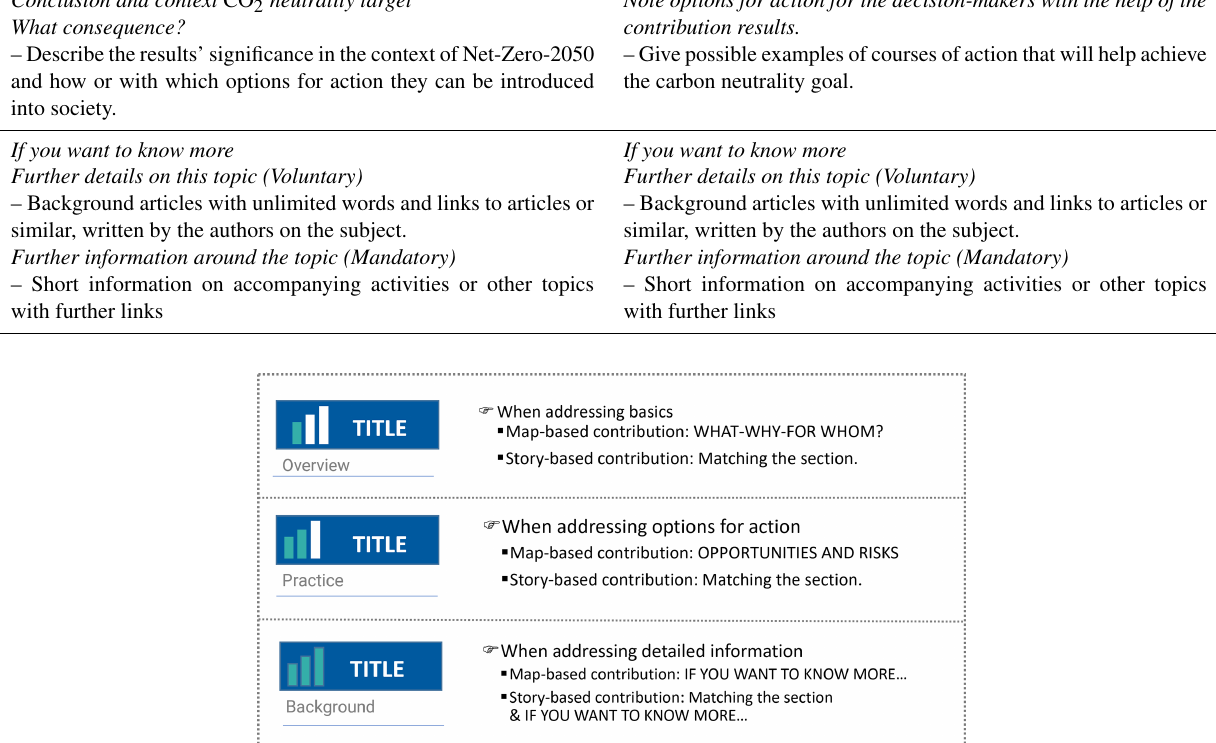
Adv. Sci. Res., 19, 51–71,